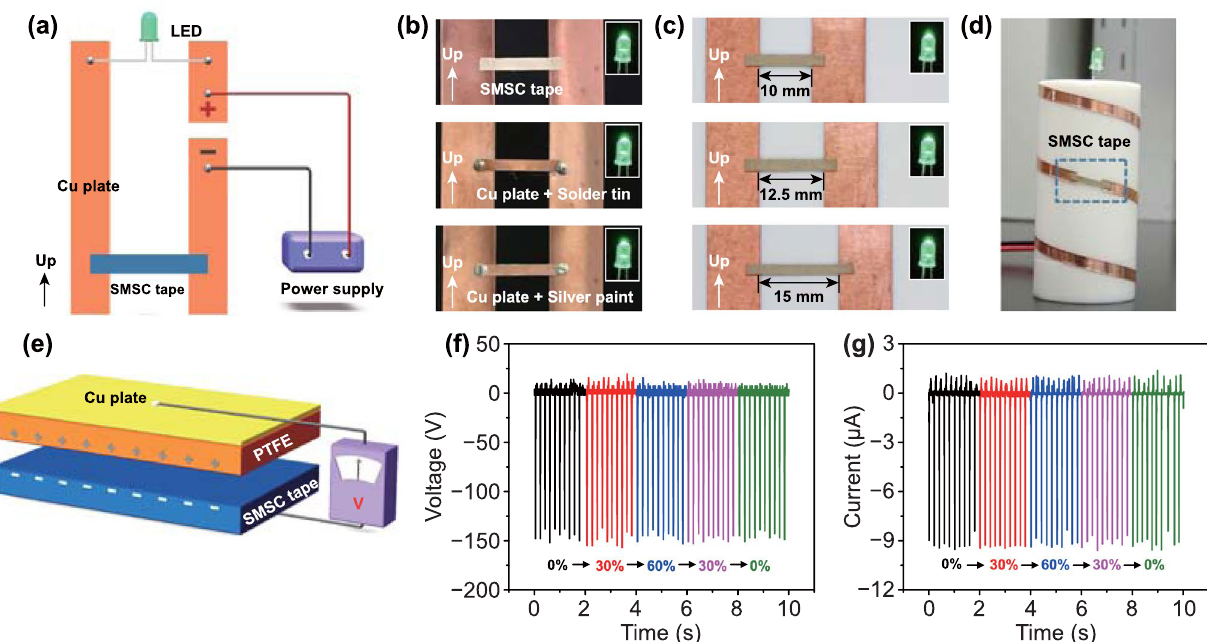
Fig. 5 Potential applications of SMSC tape. a Schematic illustration of an LED in a simple series circuit powered by a direct-current power supply. b Comparison in brightness of the working LEDs, where the circuits are repaired by SMSC tape, Cu plate and solder, and Cu plate and silver paste, respectively. c Comparison in brightness of the working LEDs, where the circuits are repaired by SMSC tape with different tensile strain. d Optical image of a circuit used to light LED. The circuit is repaired by bending SMSC tape. e Schematic illustration of a SMSC tape-based TENG. f Output voltage and g current of SMSC tape-based TENG when SMSC tape is fixed at different tensile strains in a stretching-releasing